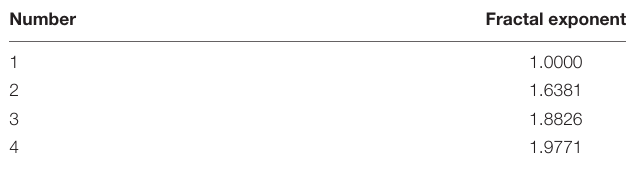
TABLE 1 | The complexity of various paths.